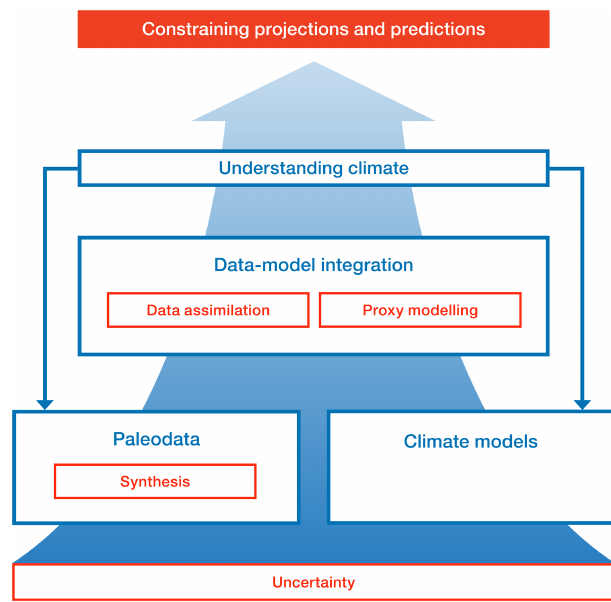
Figure 1. Schematic workflow of paleodata–model integration to improve the understanding of the climate system in order to con- strain projections and predictions of future climate. The four as- pects of the data–model integration process discussed here are high- lighted in red font. The process relies on thorough quantification and understanding of the uncertainty associated with both. For this reason uncertainty is at the base of the workflow (however, model- related uncertainty is not explicitly covered here). Further steps in this process that are covered in this special issue include data syn- thesis and data assimilation and proxy modelling as means to bring data and models